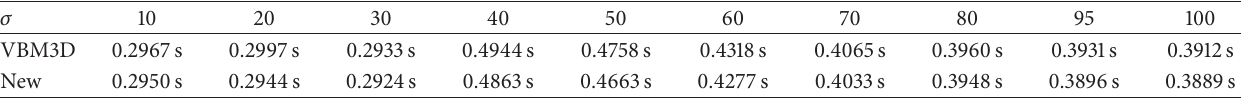
Table 1: Computational cost of the VBM3D and the proposed algorithms for the Bus video